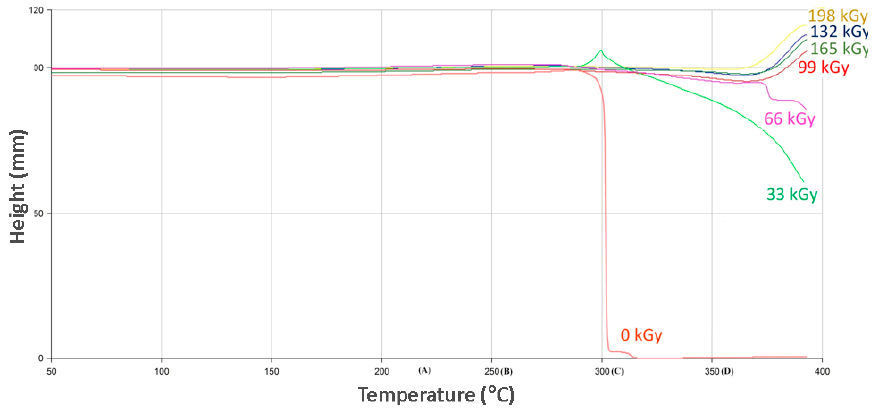
Figure 13. Thermo-mechanical analysis (PA 9T).